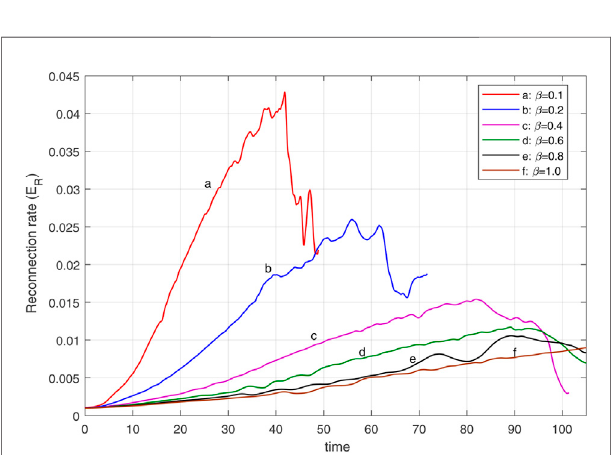
FIGURE 13 | The maximum reconnection rate for three cases.